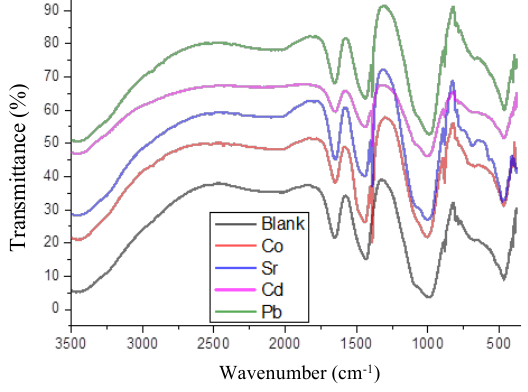
Fig. 6. FTIR spectra of geopolymers with and without the addition of heavy metal ions